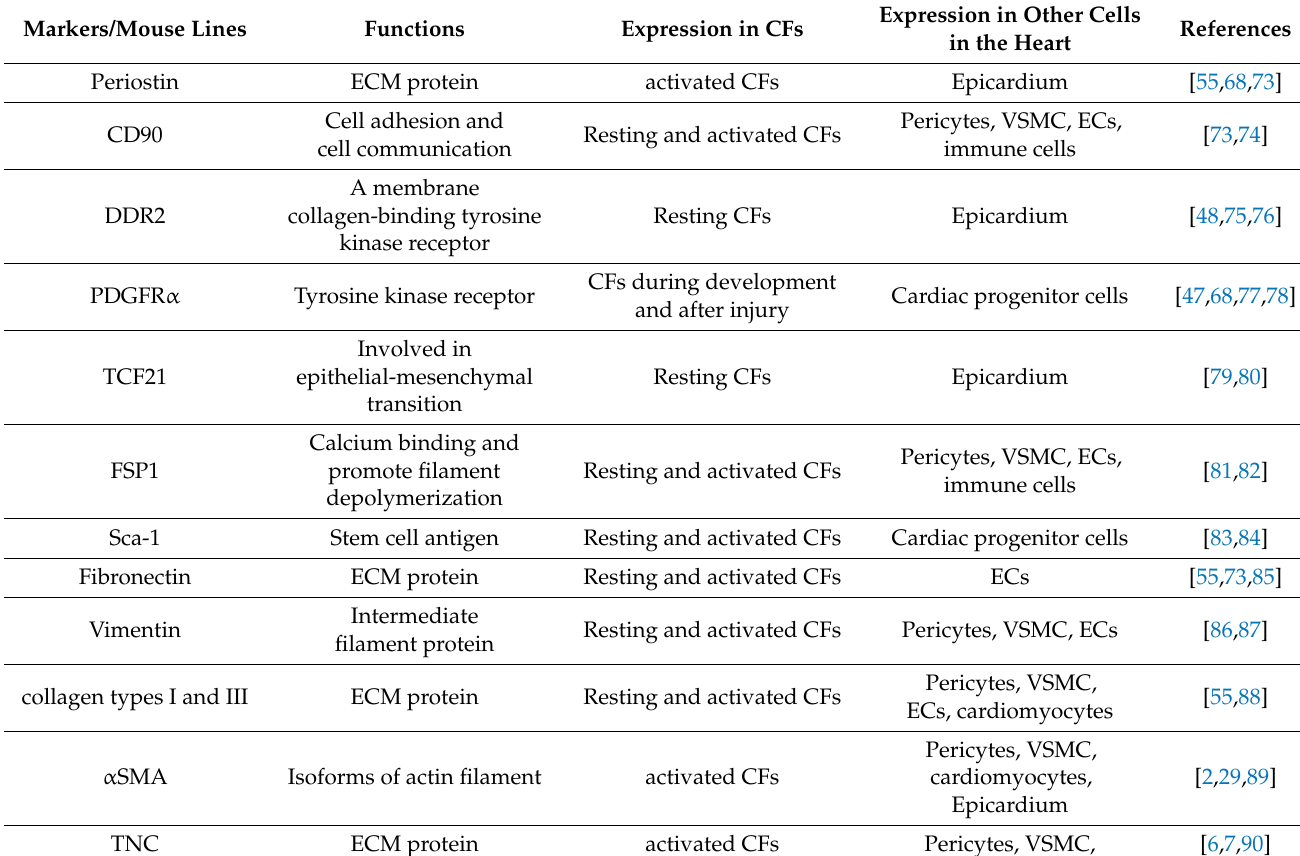
Table 1. Marker proteins:DDR2, discoidin domain receptor 2; PDGFR α , platelet derived growth factor receptor α ; TCF21, Transcription factor 21; FSP1, fibroblast specific protein 1; Sca-1, stem cell antigen-1; α SMA, α smooth muscle actin; TNC, tenascin-C. Modified from